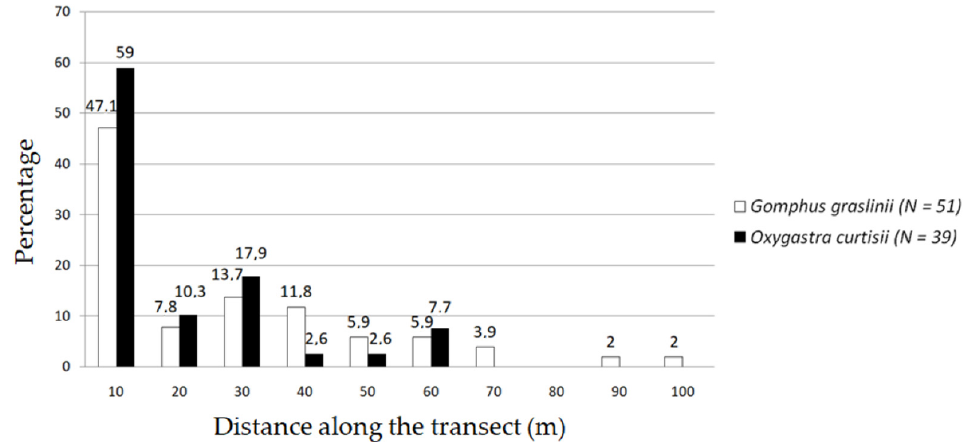
Figure 9. Distribution of the first detection of Gomphus graslinii and Oxygastra curtisii along the 100 m long transects ( n = number of positive transects for each species).